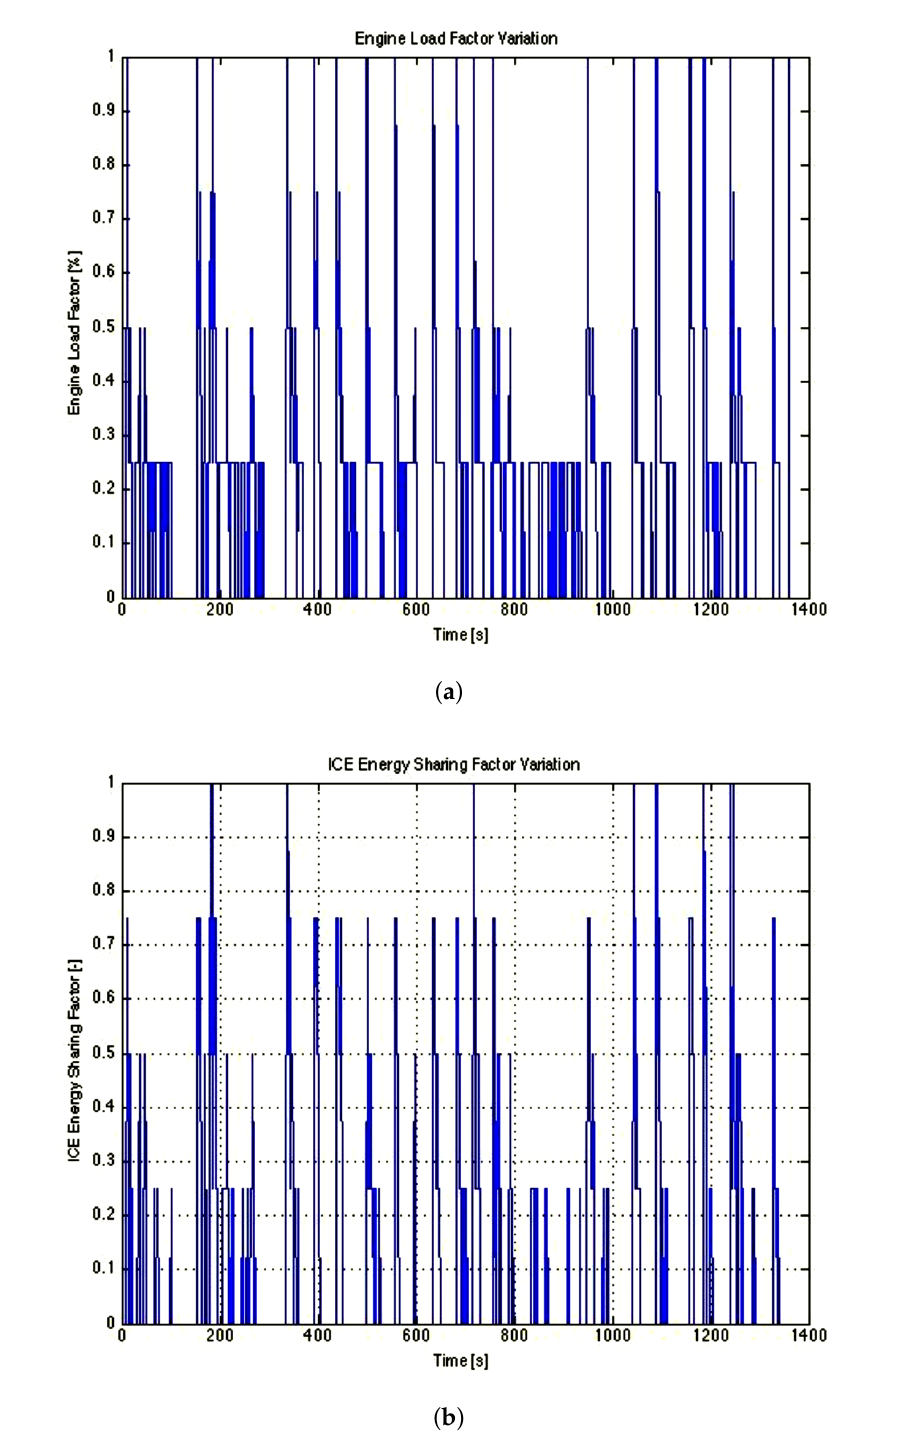
Figure 8. FUDS driving cycle. ( a ) ICE load factor; ( b ) ICE energy sharing